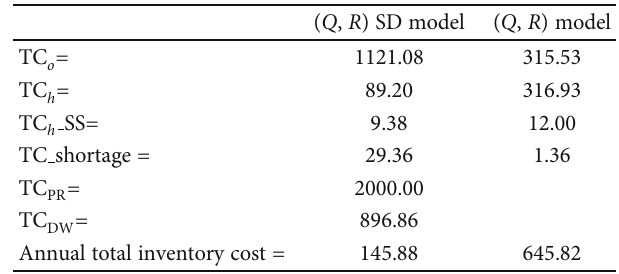
. E Table 10: Comparison of total annual costs of the ( Q , R ) model with SD criteria and the standard ( Q , R )